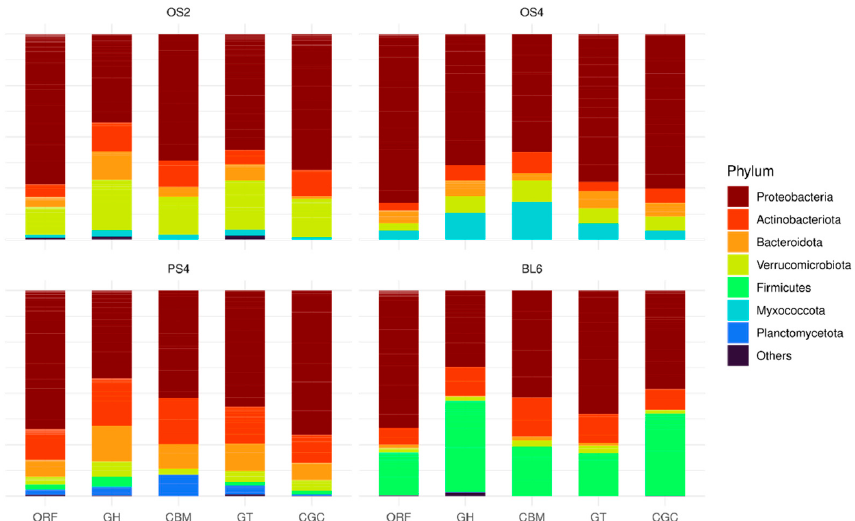
Figure 7. Taxonomic composition on the phylum level in the four cellulolytic consortia (OS2, OS4, PS4, BL6), based on ORFs, GHs, CBMs, GTs, and CGCs annotations. To look into functional unevenness between consortia on the deeper taxonomic level,